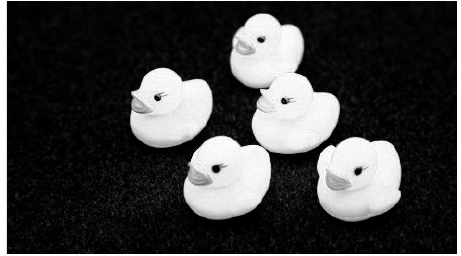
Figure 5. Result of dilation of the original